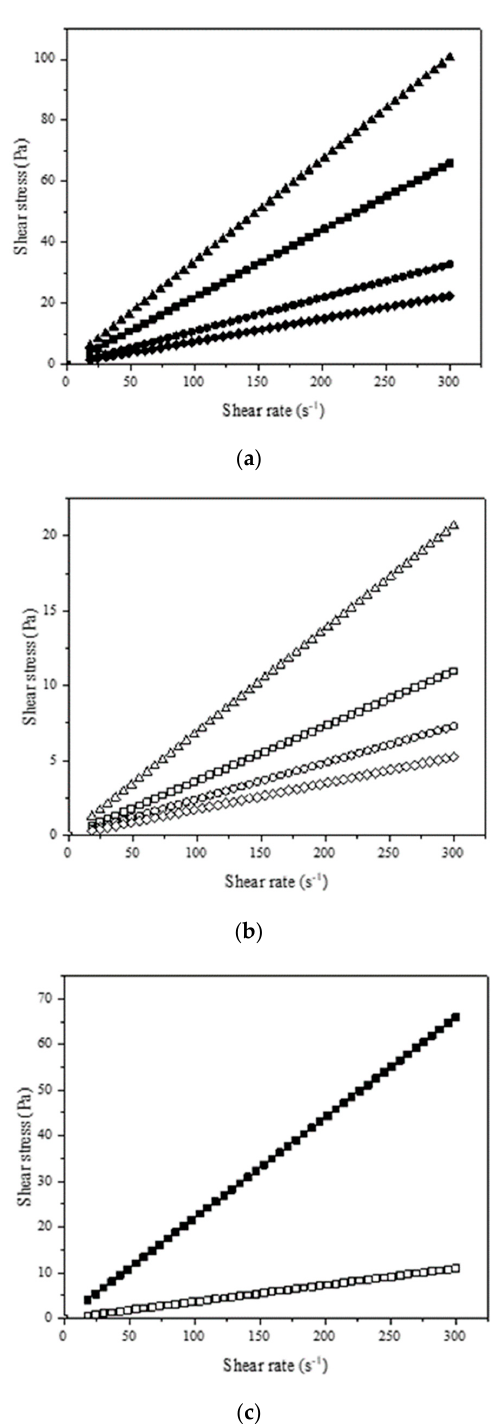
Figure 7. Flow curves for NADESs fitted to Newton model at 40 °C. ( a ) Solid symbols represent NADESs without the addition of water ( ■ lactic acid:glycine; ● lactic acid:ammonium acetate; ▲